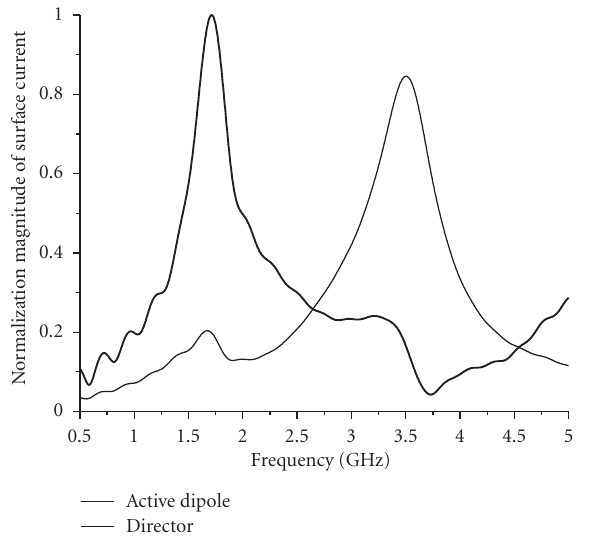
Figure 3: Simulated results of antenna surface current